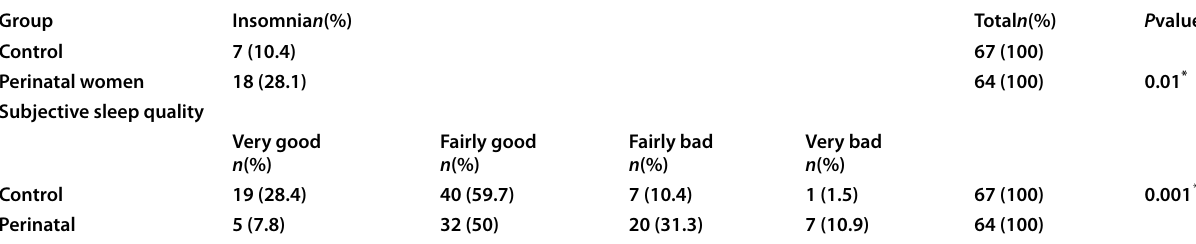
Table 2 Prevalence of insomnia and subjective sleep quality among the studied groups